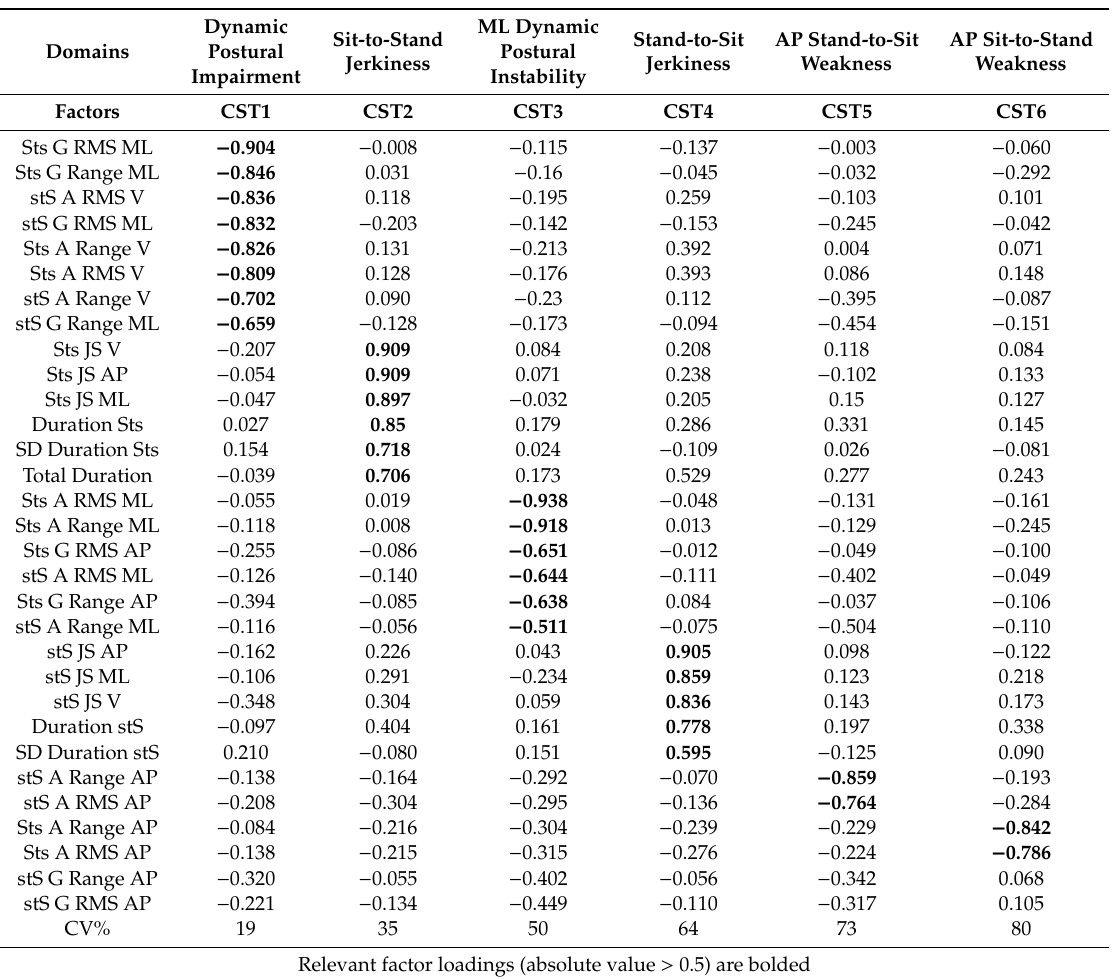
Table 7. CST factor model: Factor loadings of the sensor-based measures, corresponding domains and Cumulative Variance (CV) (Varimax